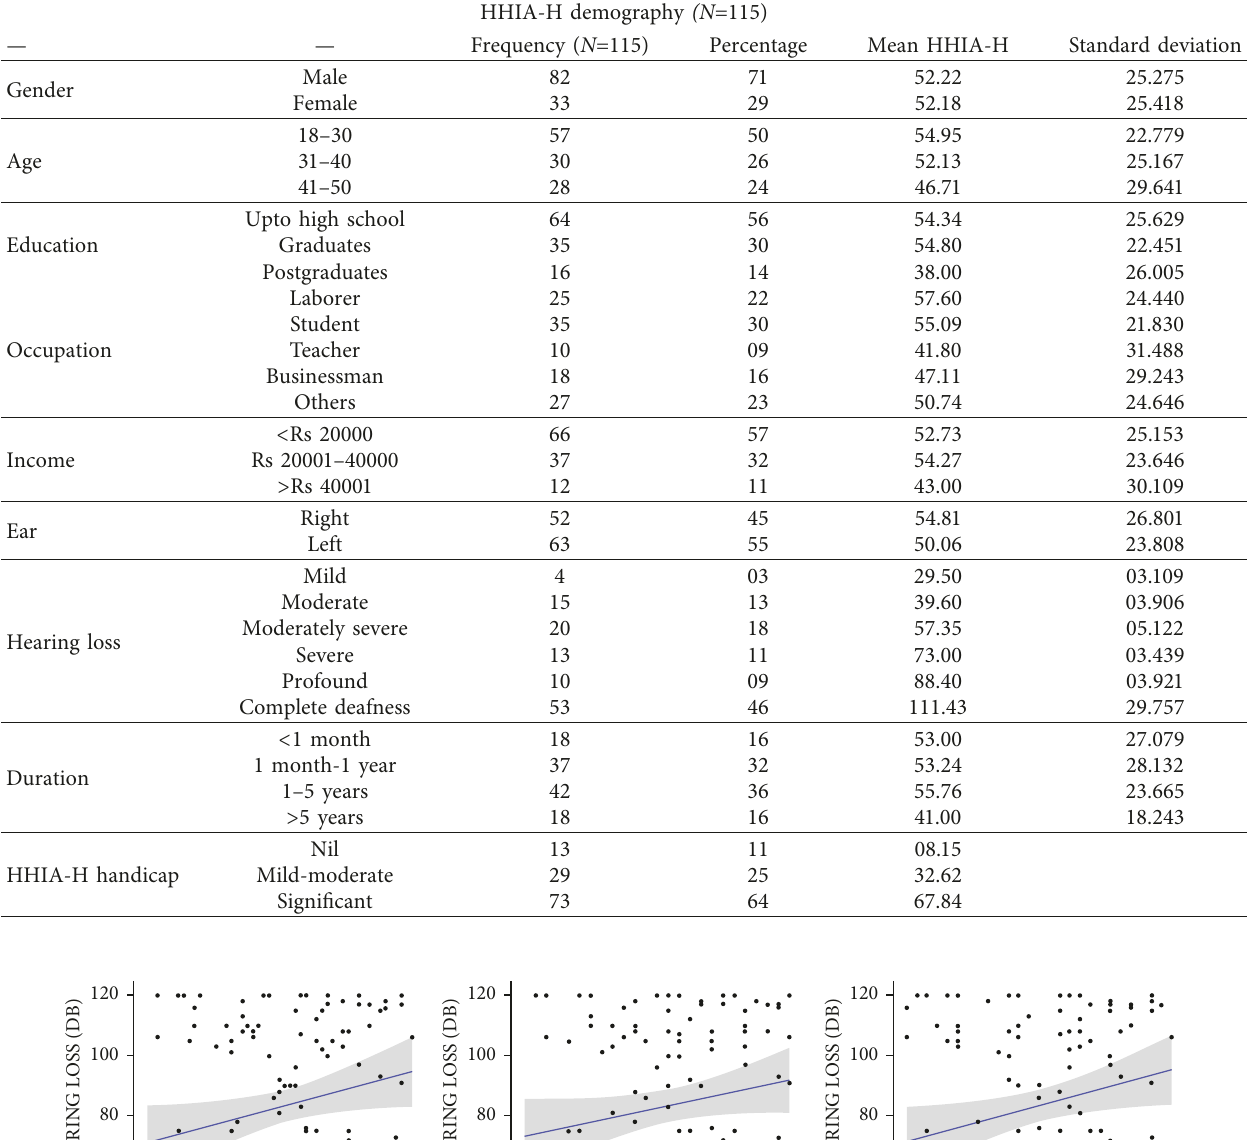
Table 1: HHIA profile of patients with USNHL ( N